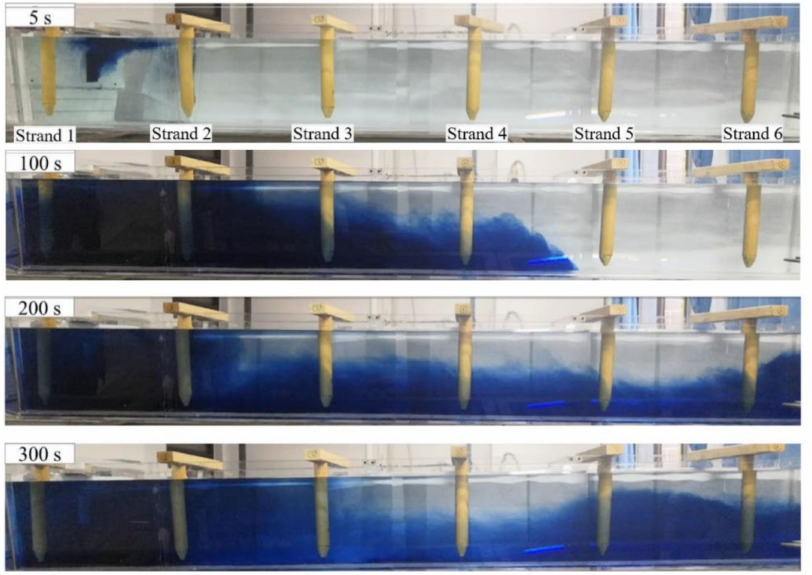
Figure 4. Tracer concentration distribution in six-strand tundish.